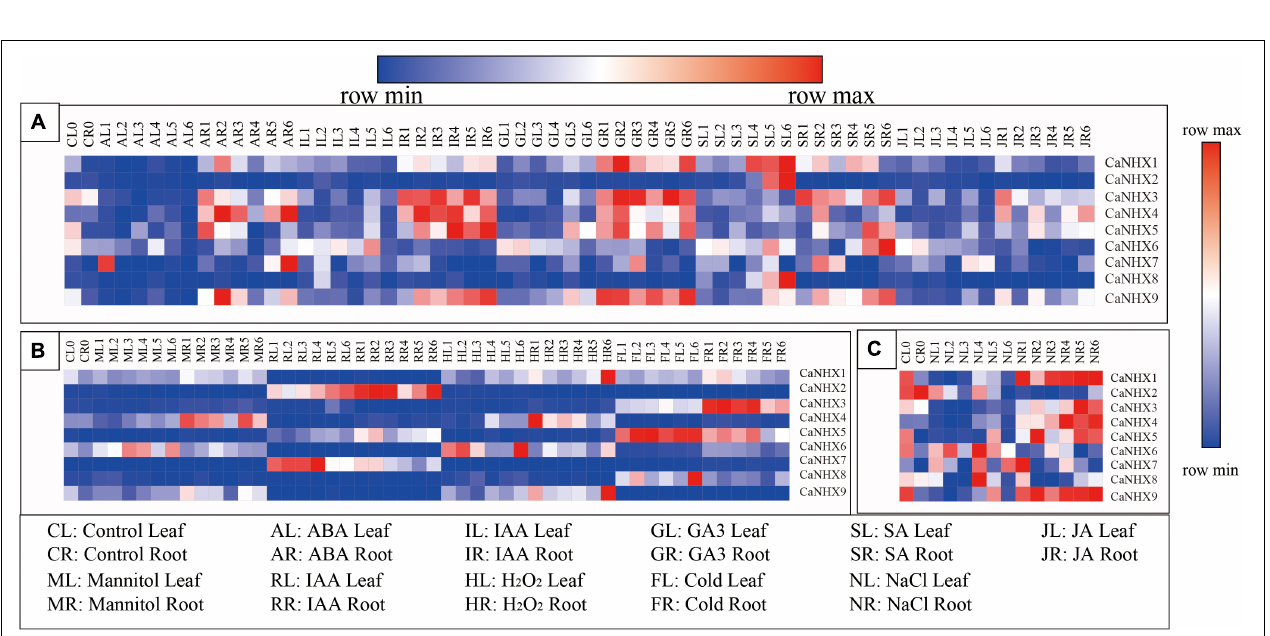
FIGURE 8 | Expression pattern of CaNHX gene in pepper under different stress in root and leaf. (A) Hormonal stress. (B) Abiotic stress. (C) Salt stress.